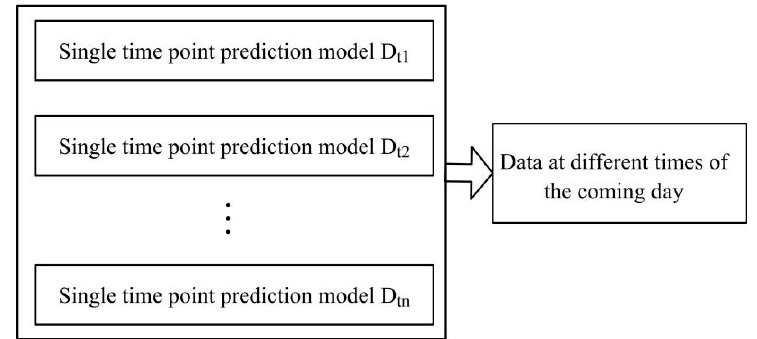
Figure 3. Integrated predictive control model for the next day.